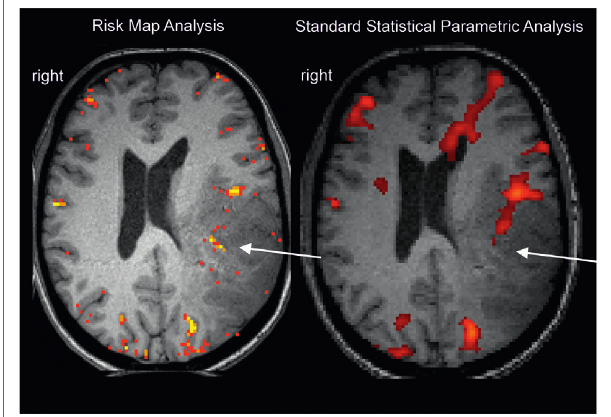
FiGuRe 1 | Example for a missing language activation (Wernicke activity, white arrow) with a “black box” standard analysis (right, SPM12 applying motion regression and smoothing, voxelwise inference FWE < 0.05, standard k = 25) using an overt language design [described in Ref. (17)]. Wernicke activity is detectable with the clinical risk map analysis (left) based on activation replicability (yellow = most reliabel voxels). Patient with left temporoparietal